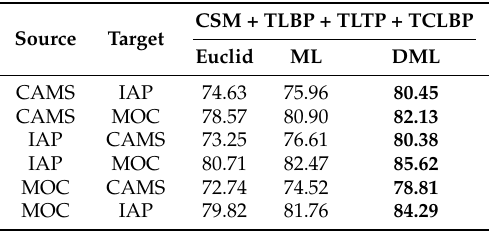
Table 7. After IGC, FN, and the concatenation of the TLBP, TLTP and TCLBP, cross-domain classification accuracies (%) of CSM with different metrics.